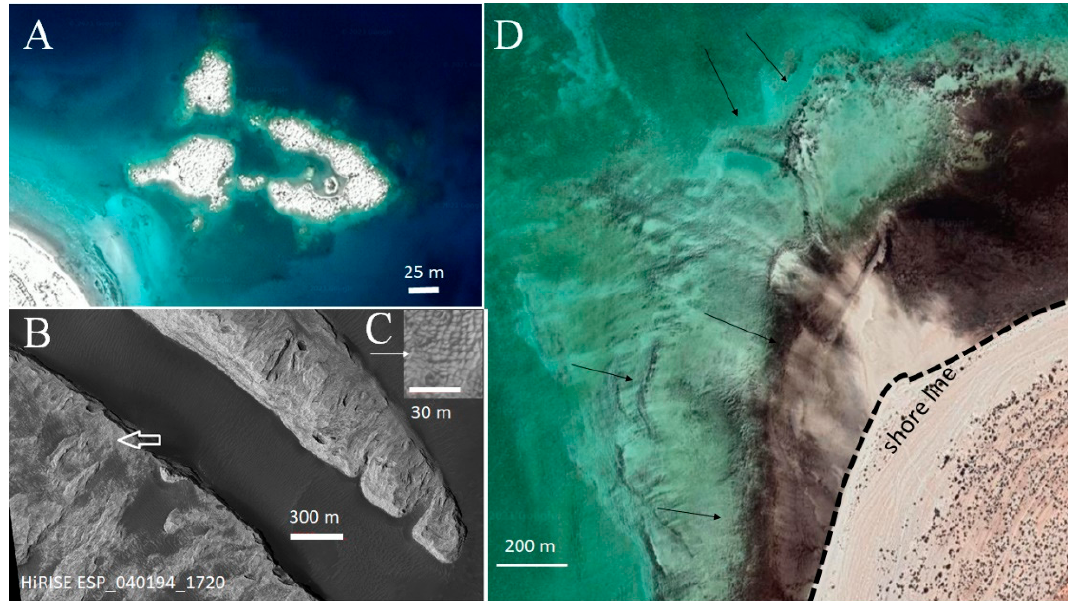
Figure 19. ( A ) Stromatolites in Lake Salda, Turkey. Image courtesy of Google Earth. ( B ) The “white rock” inside crater Pollack, Mars. HiRISE image. ( C ) Detail of the area in ( B ) indicated with an arrow. ( D ) Stromatolites in Shark Bay. Image courtesy of Google Earth.